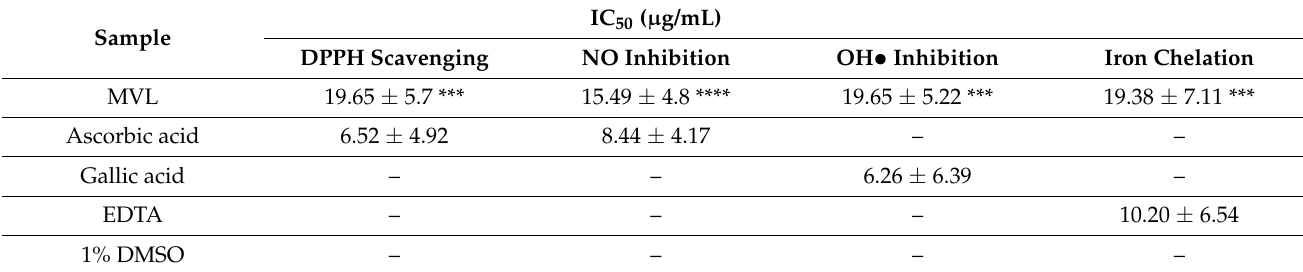
Table 1. Assessment of in vitro antioxidant potential (IC 50 : µ g/mL) of MVL.